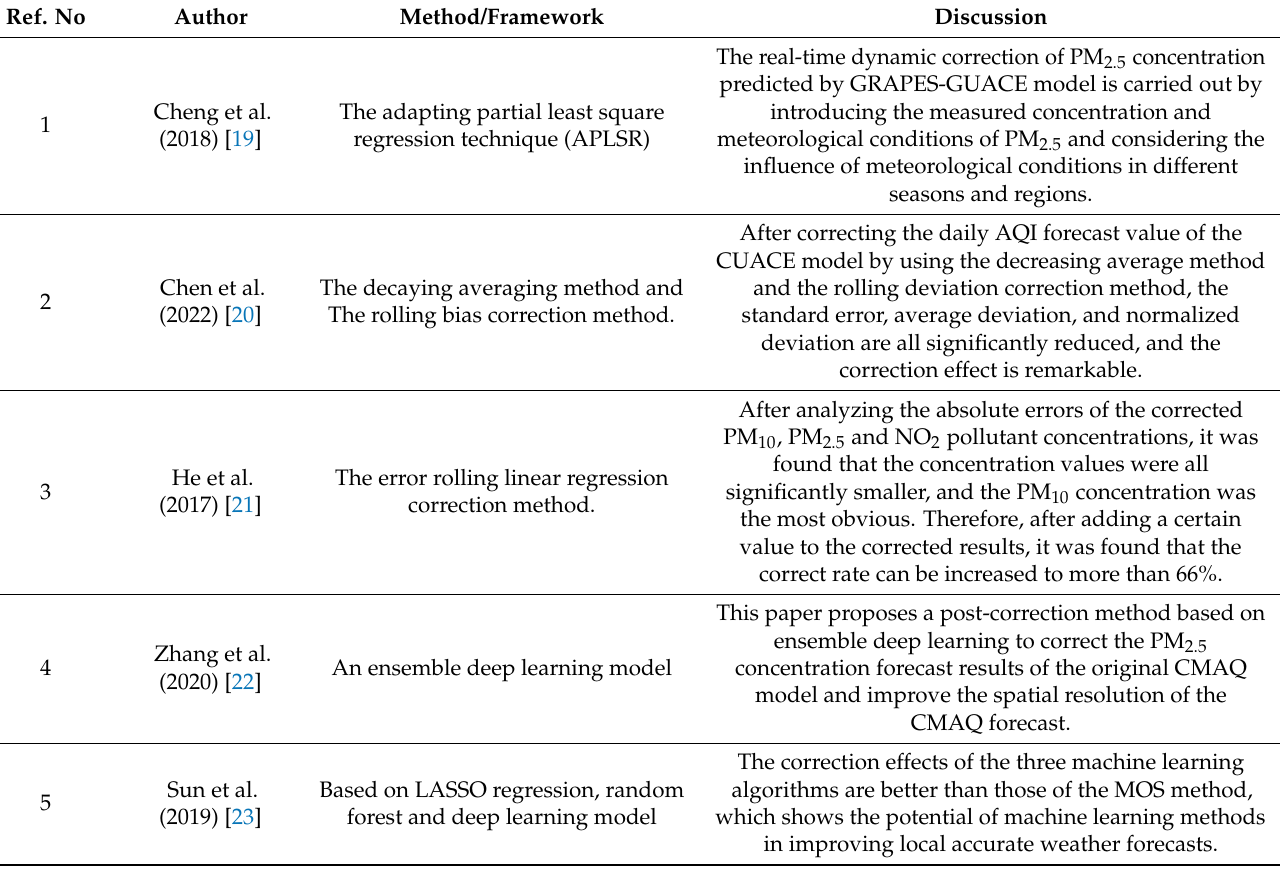
Table 1. Summary of related